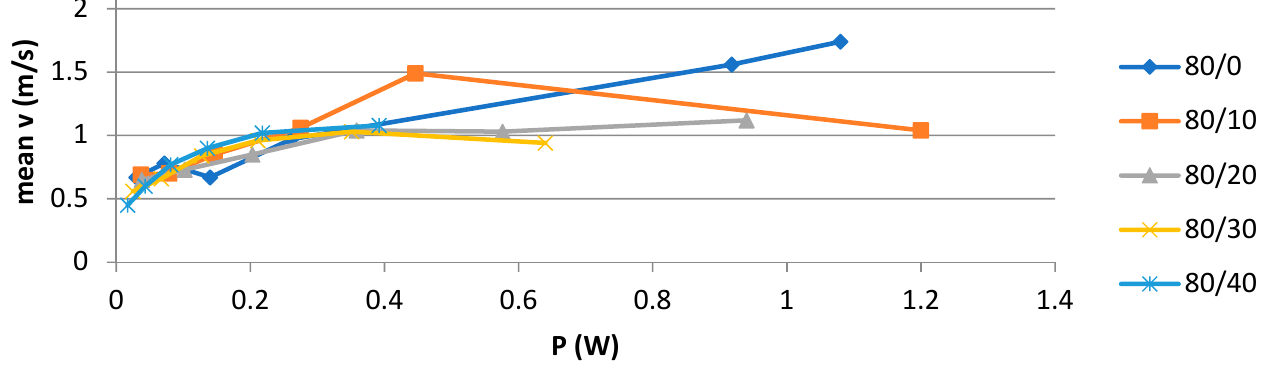
Figure 4. Measured mean velocity in the relation to the power consumption on the airflow generator with a = 100 mm for five different electrode gaps g = 0–40 mm.